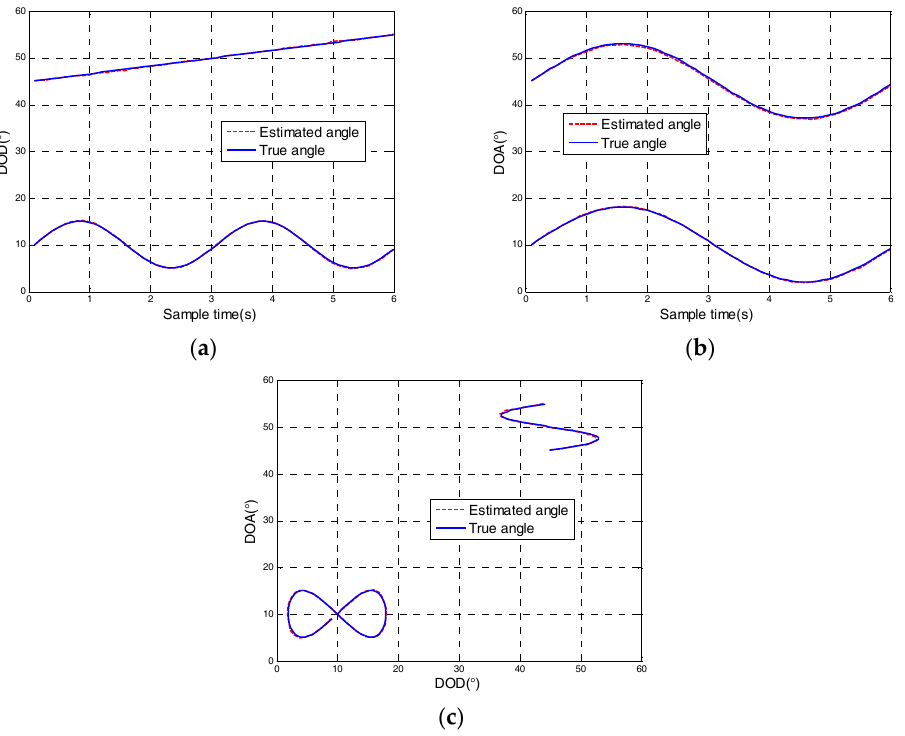
Figure 3. Angle tracking results of non-uniform moving targets with SNR = 15 dB: ( a ) The direction of departure; ( b ) The direction of arrival; ( c ) DOD and DOA trajectory.